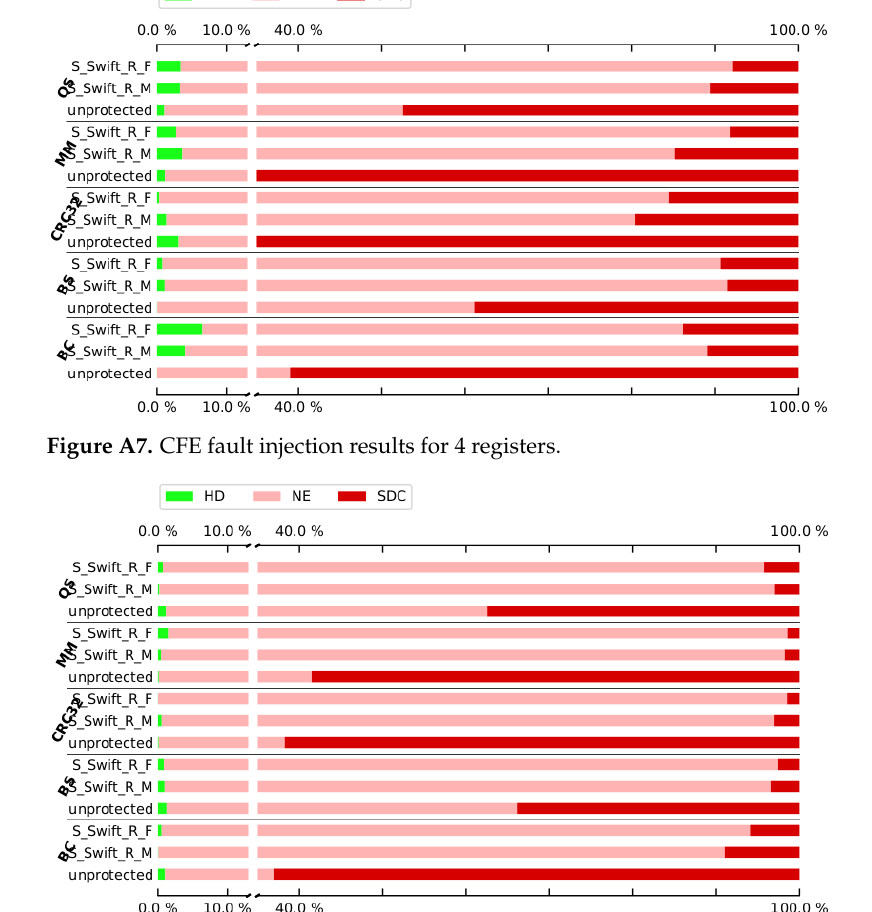
Figure A8. DFE fault injection results for 4